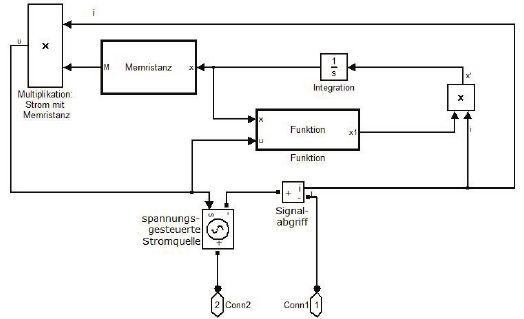
Fig. 16 : Implementation of the HP memristor in Matlab